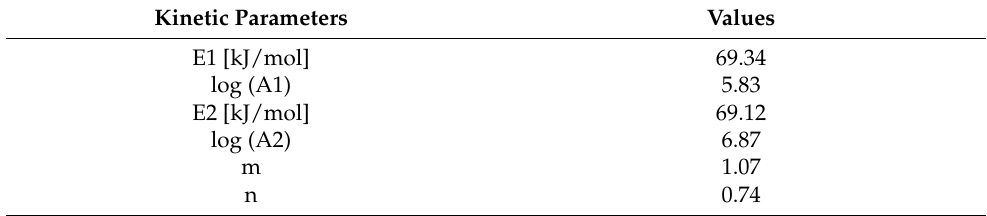
Table 3. Kinetic parameters determined using the Kamal-Sourour model based on isothermal DEA data.